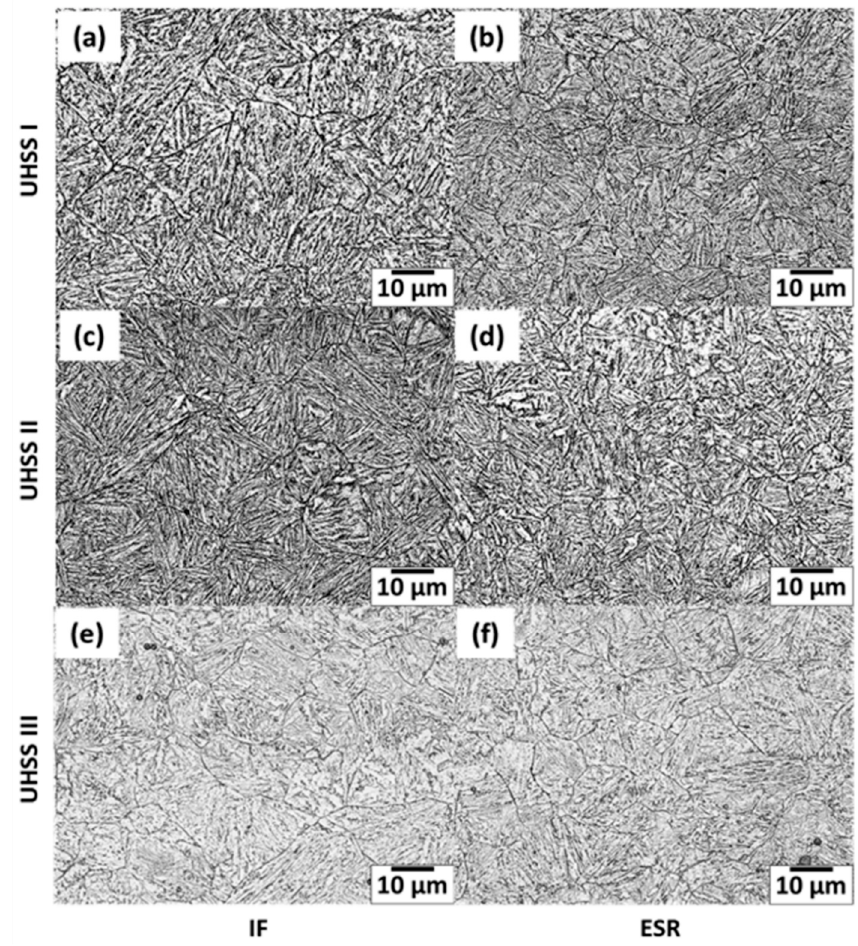
Figure 5. LSCM micrograph of PAG of forged and air-cooled bars of UHSS I, II, and III without ESR ( a , c , e ) and with ESR ( b , d , f ).